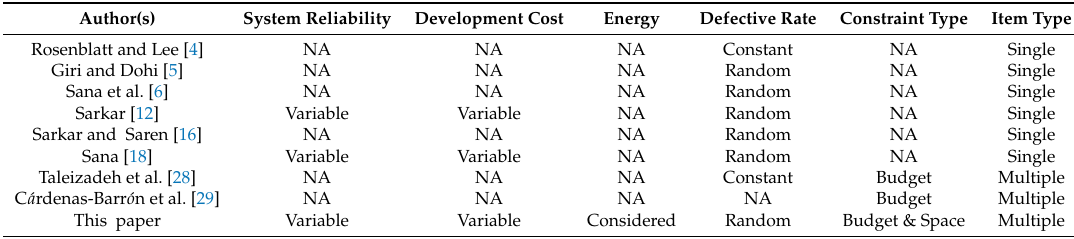
Table 1. Research contribution by several